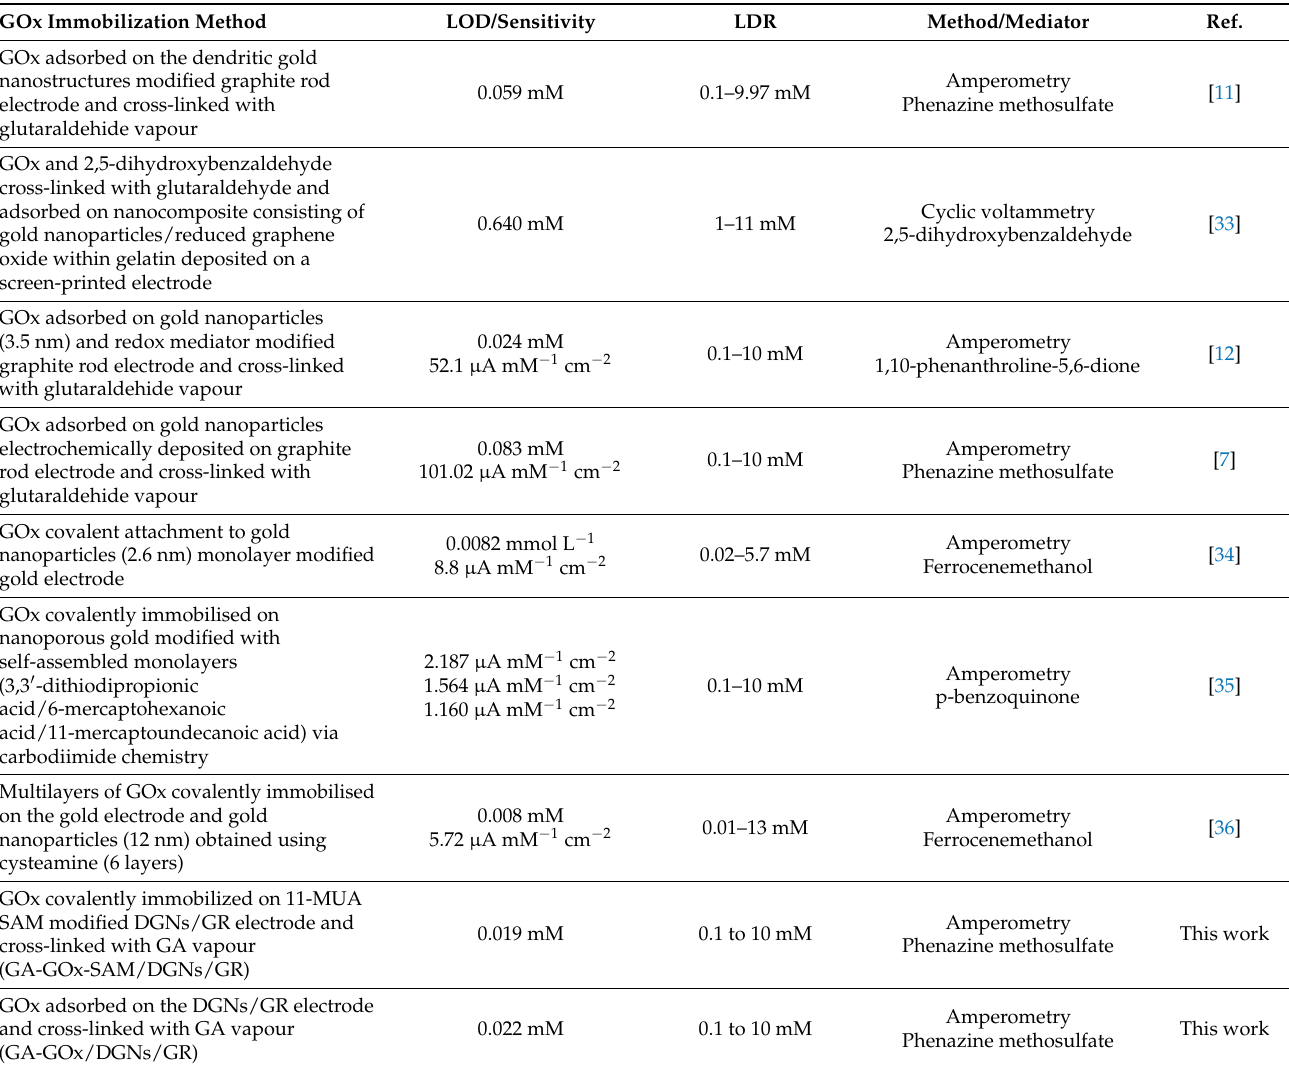
Table 1. Comparison of glucose oxidase immobilization method on the performance of glucose biosensors with different gold